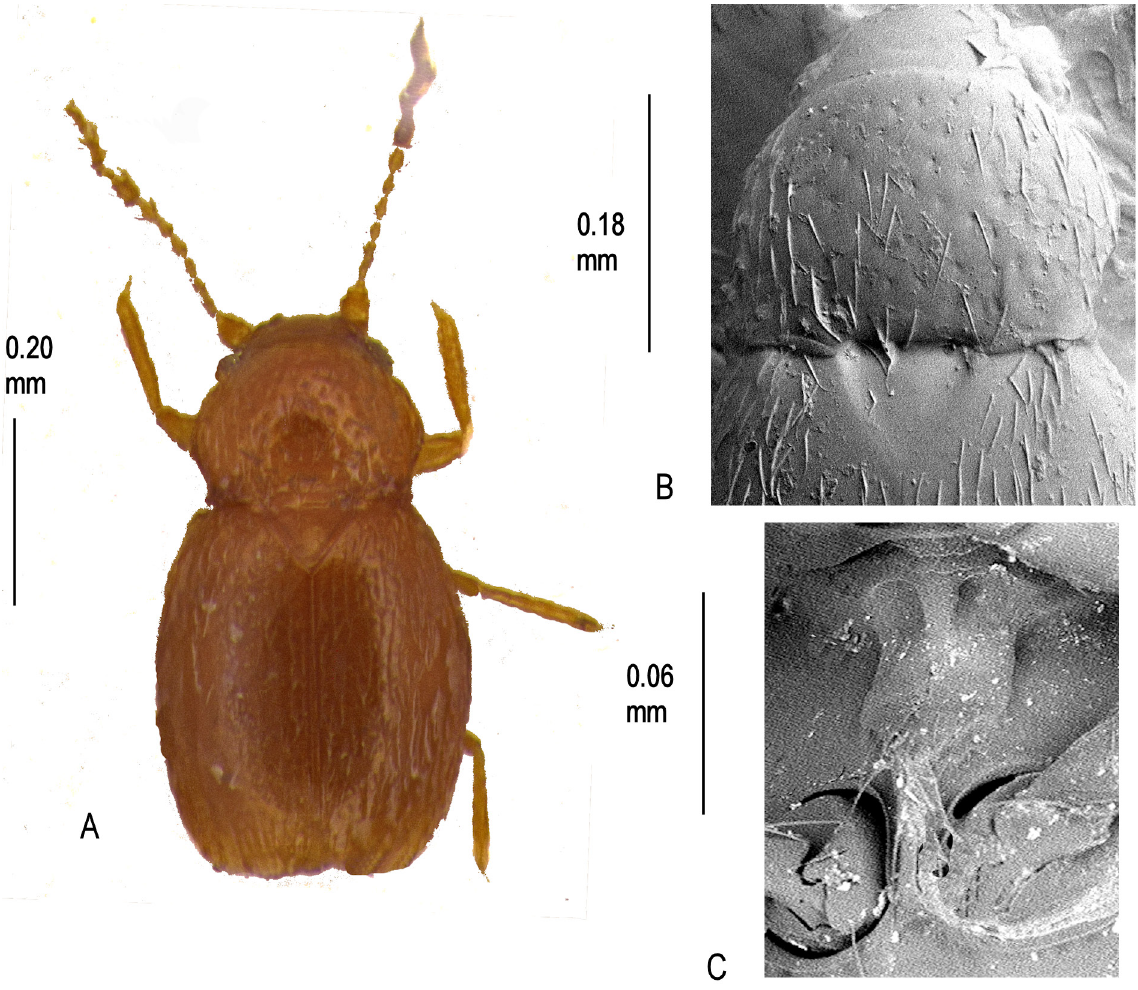
Fig. 84 . Cissidium trangse sp. nov. A . Habitus. B . Pronotum, × 480. C . Mesoventrite showing median process of collar, mid-keel and keel,